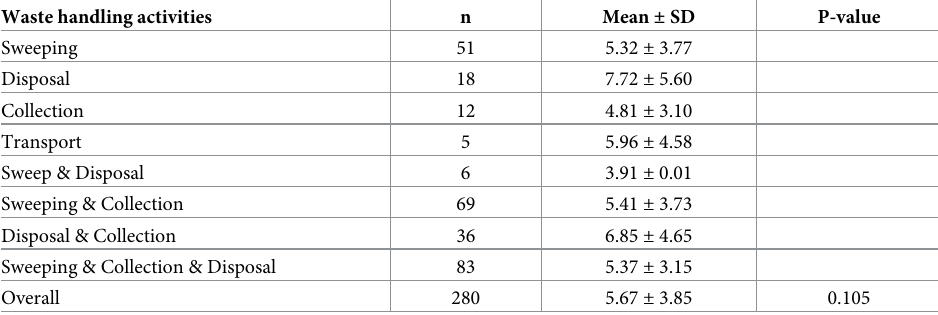
Mean log difference: Row mean log–Column mean log. P-values from paired t-test, unit of measurement for mean log concentrations of E. coli was CFU/hand.